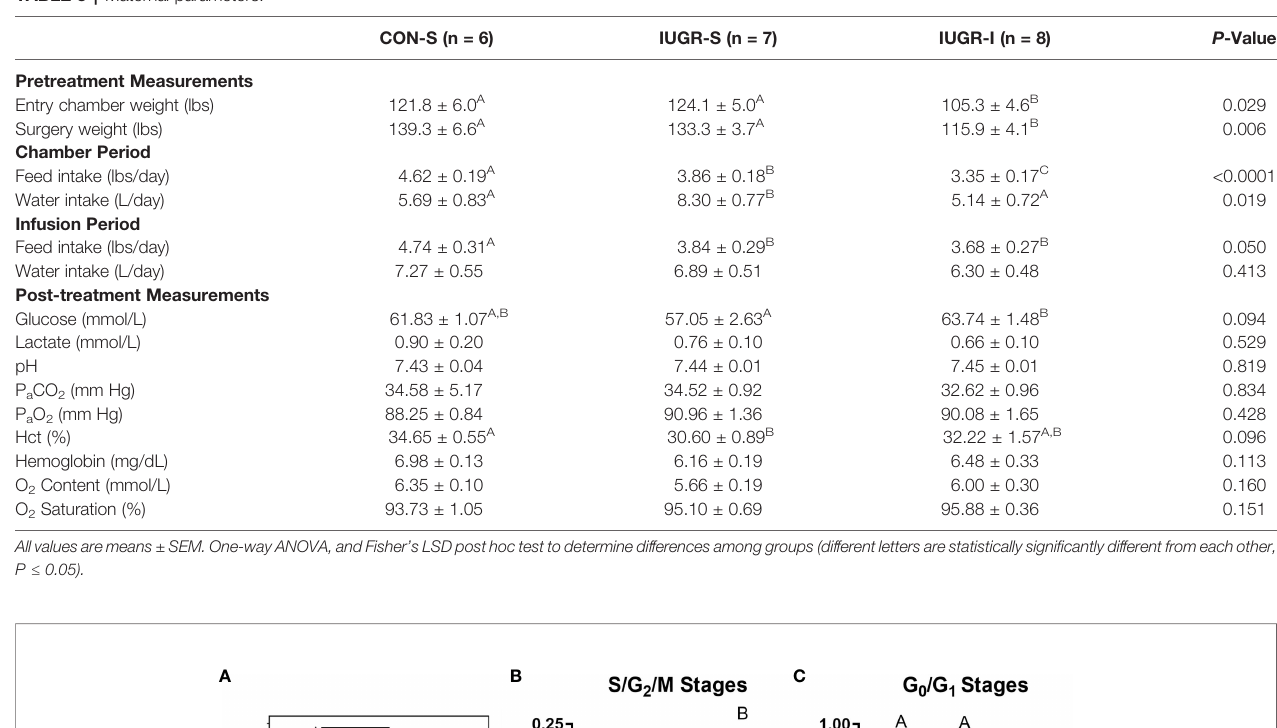
TABLE 3 | Maternal parameters.